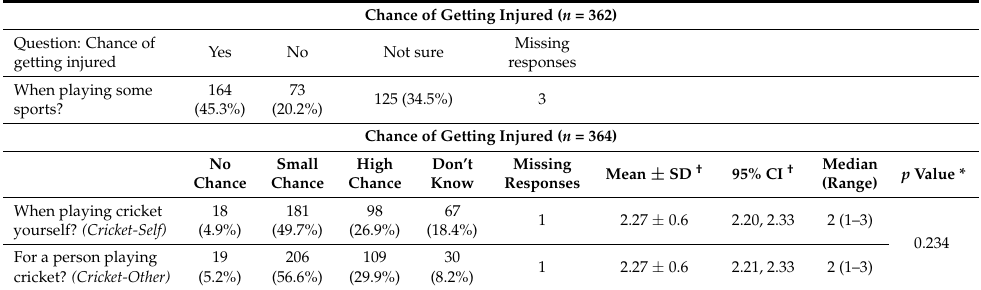
Table 1. Frequency and percentage (%) of perceived injury risk for self and others when playing sport, and when playing cricket.